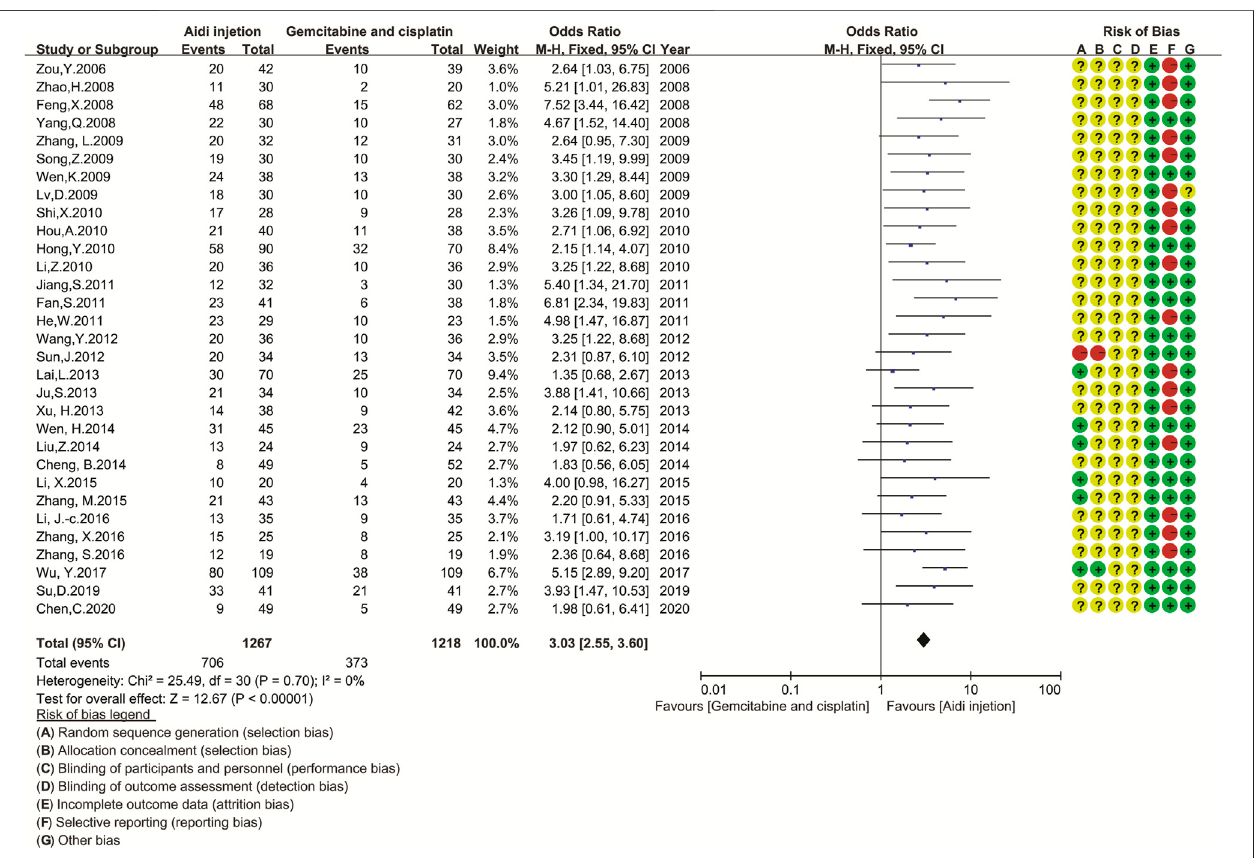
FIGURE 4 | The analysis of QOL between two groups. The pooled result showed a signi fi cant improvement in QOL in the Aidi and GP combination compared to that in the control group (OR (cid:1) 3.03, 95% CI [2.55 to 3.60], p < 0.00001). Note: GP, Gemcitabine and cisplatin; QOL, quality of life.